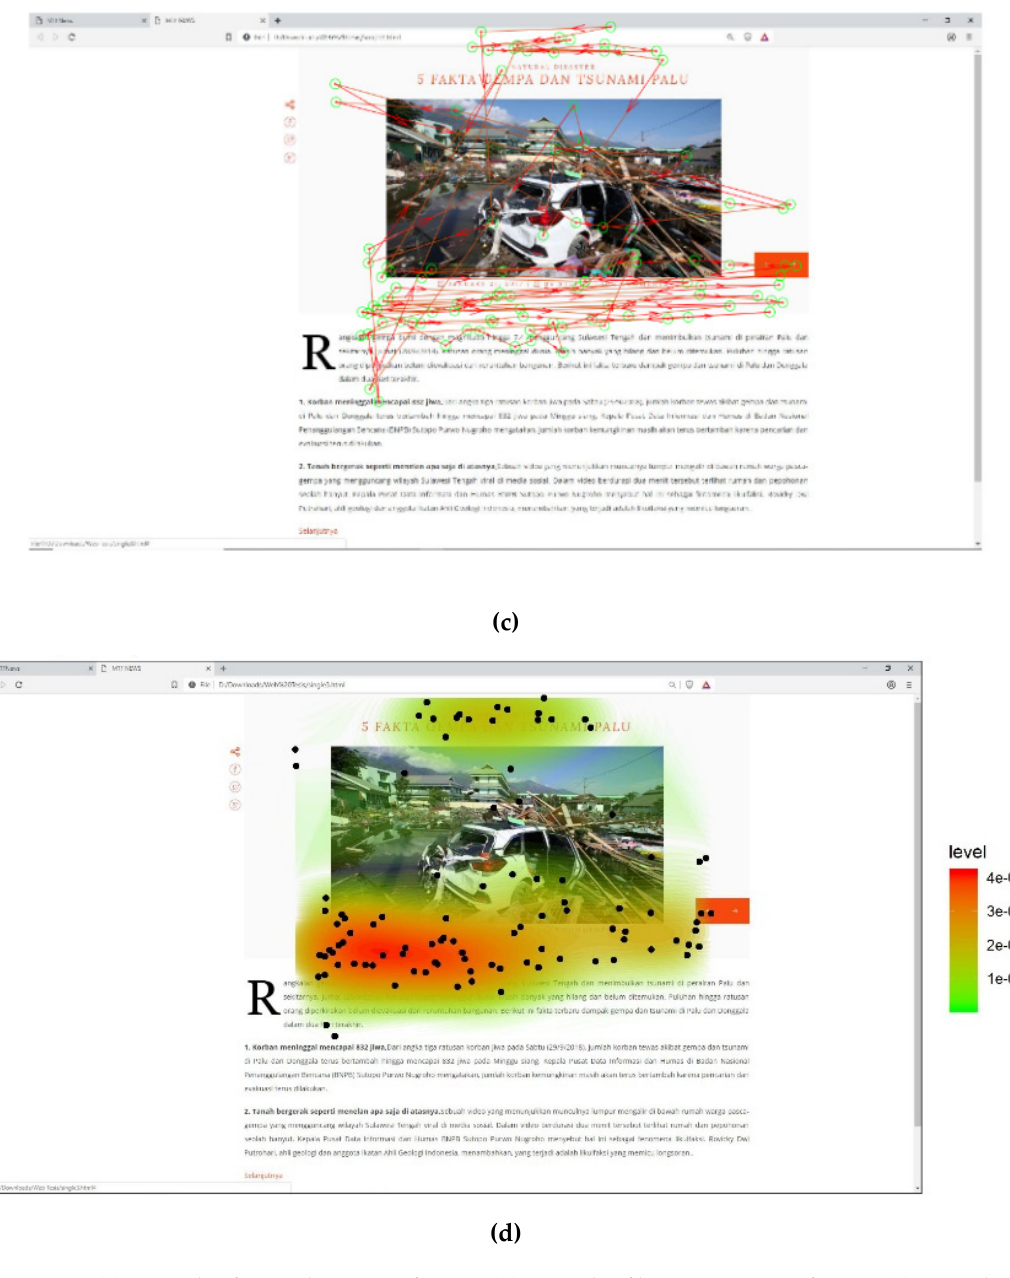
Figure 3. ( a ) Example of gaze plot text preference; ( b ) example of heat map text preference; ( c ) example of gaze plot image preference; ( d ) example of heat map image preference.